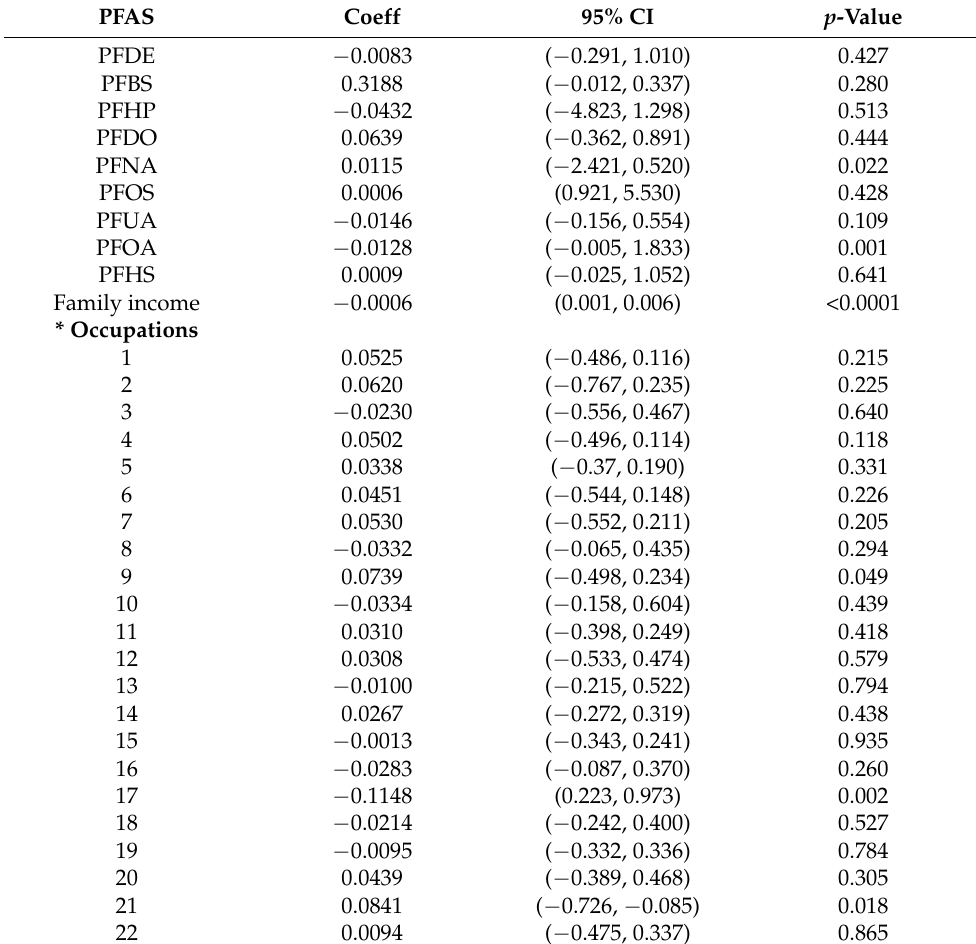
Table 5. Poisson models used to assess the association of AL with PFAS, occupation, and annual family